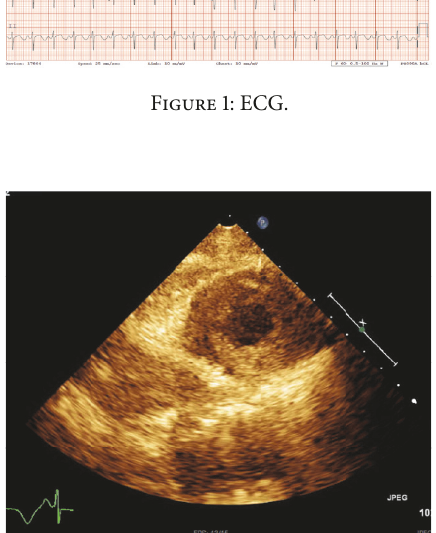
Figure 2: Echocardiogram showing apical hypokinesia.